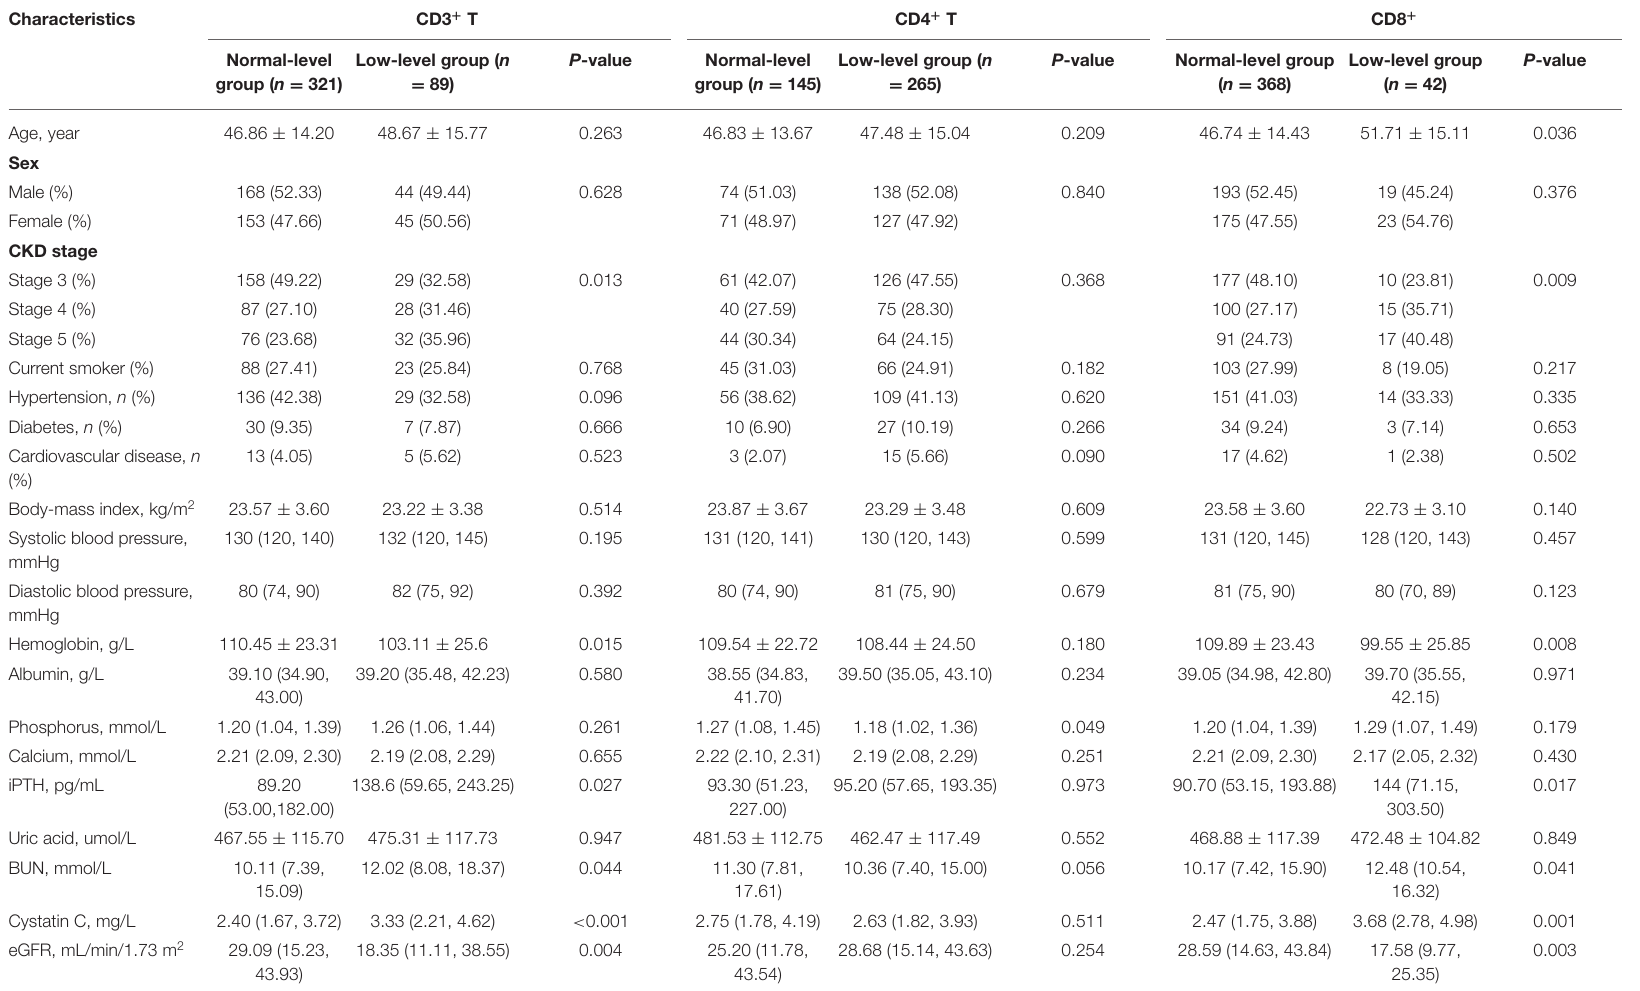
TABLE 3 | Demographic, clinical and laboratory parameters in accordance with CD3 + , CD4 + and CD8 + T cells.